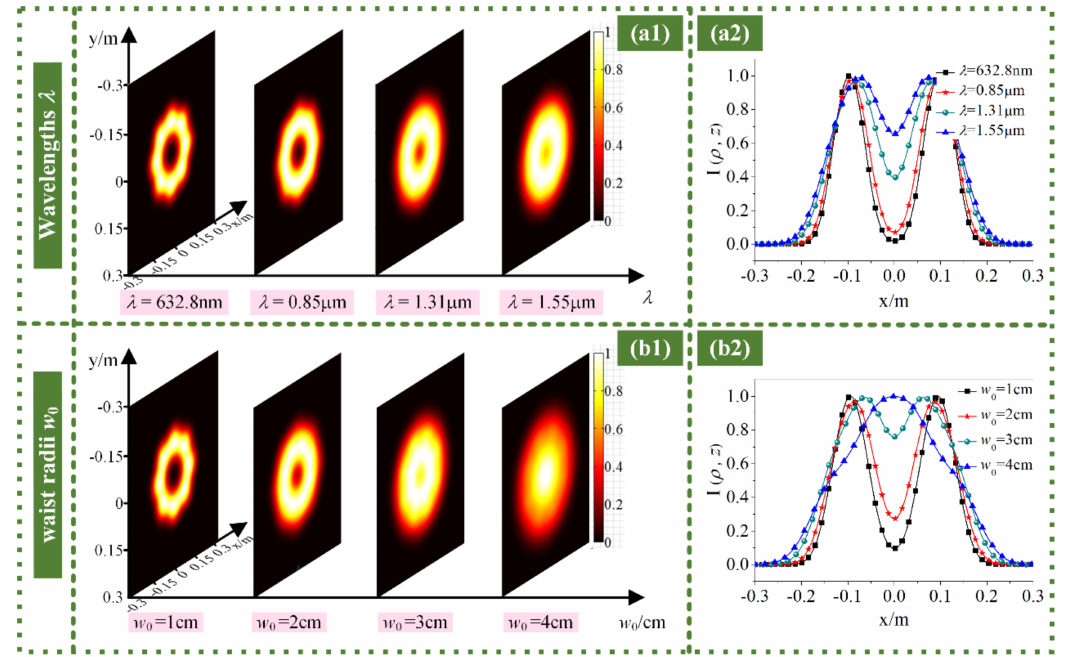
Figure 5. Intensity ( a1 , b1 ) distributions and ( a2 , b2 ) profiles of the RPLPCV beam array propagated through non- Kolmogorov turbulence for different ( a ) wavelengths; ( b ) waist